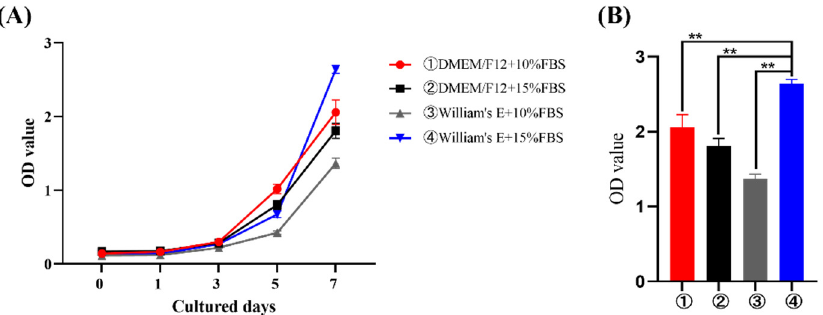
Figure 7. Proliferation assessment of sheep primary hepatocytes. ( A ) CCK-8 assay results of the proliferation of primary sheep hepatocytes cultured using four different culturing methods at days 0, 1, 3, 5, and 7. ( B ) Comparison of the OD of cultured cells on the 7th day. **, p < 0.01; ns, no signif- icance.